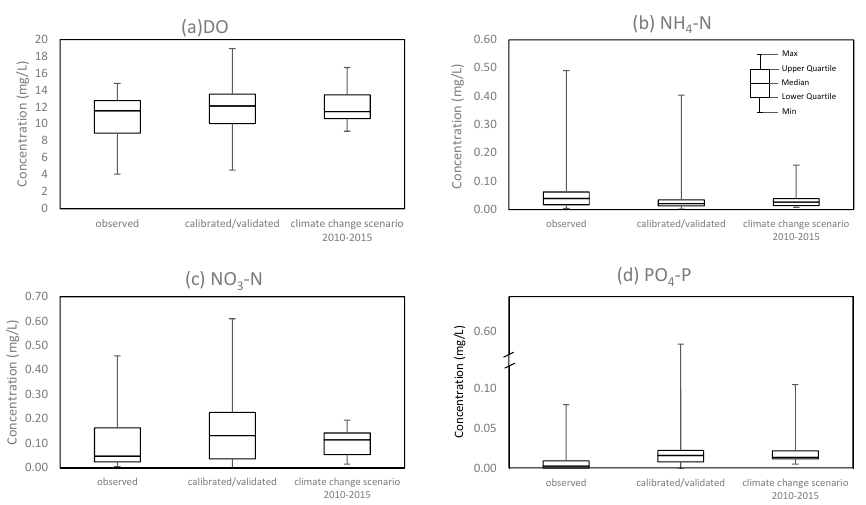
Figure 9. Measure and simulated water quality parameter concentrations using calibrated/validated model and climate change scenario models ( a ) DO; ( b ) NH 4 -N; ( c ) NO 3 -N; and ( d ) PO 4 -P. Figures 10 and 11 show the climate change impact on water quality parameters for 2050–2055 and 2080–2085. The outputs from the RCP 8.5 scenario, which represents the highest greenhouse gas emissions, indicate the largest change in water quality of the system. As might be expected, all the water quality parameters in the 2080–2085 period showed a bigger change than in the 2050–2055 period, except for a few cases (e.g., NH 4 in September using the RCP 2.6 scenario).